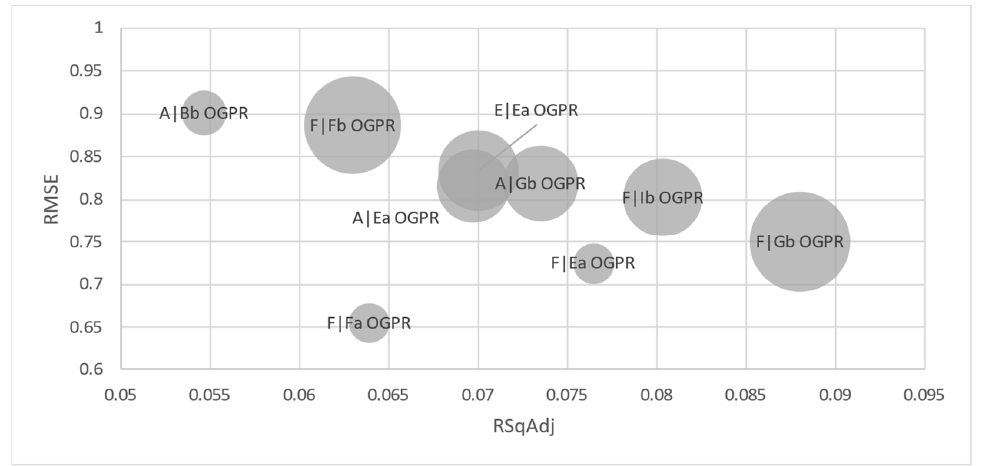
Figure 6. RMSE values for optimized Gaussian process results of two predictors, grouped by fami- lies tested (bubble size represents number of observations).